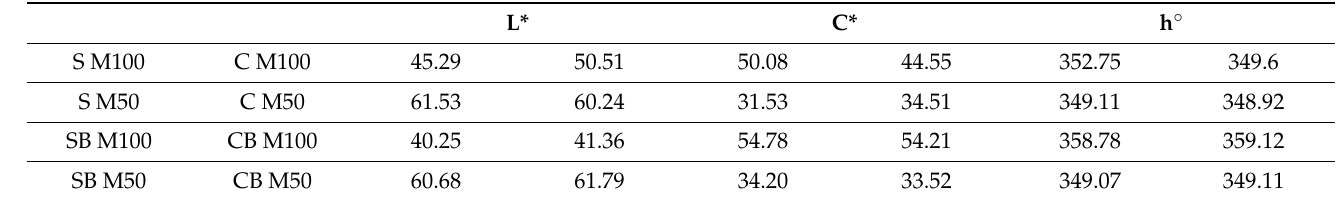
printed with magenta pigment.